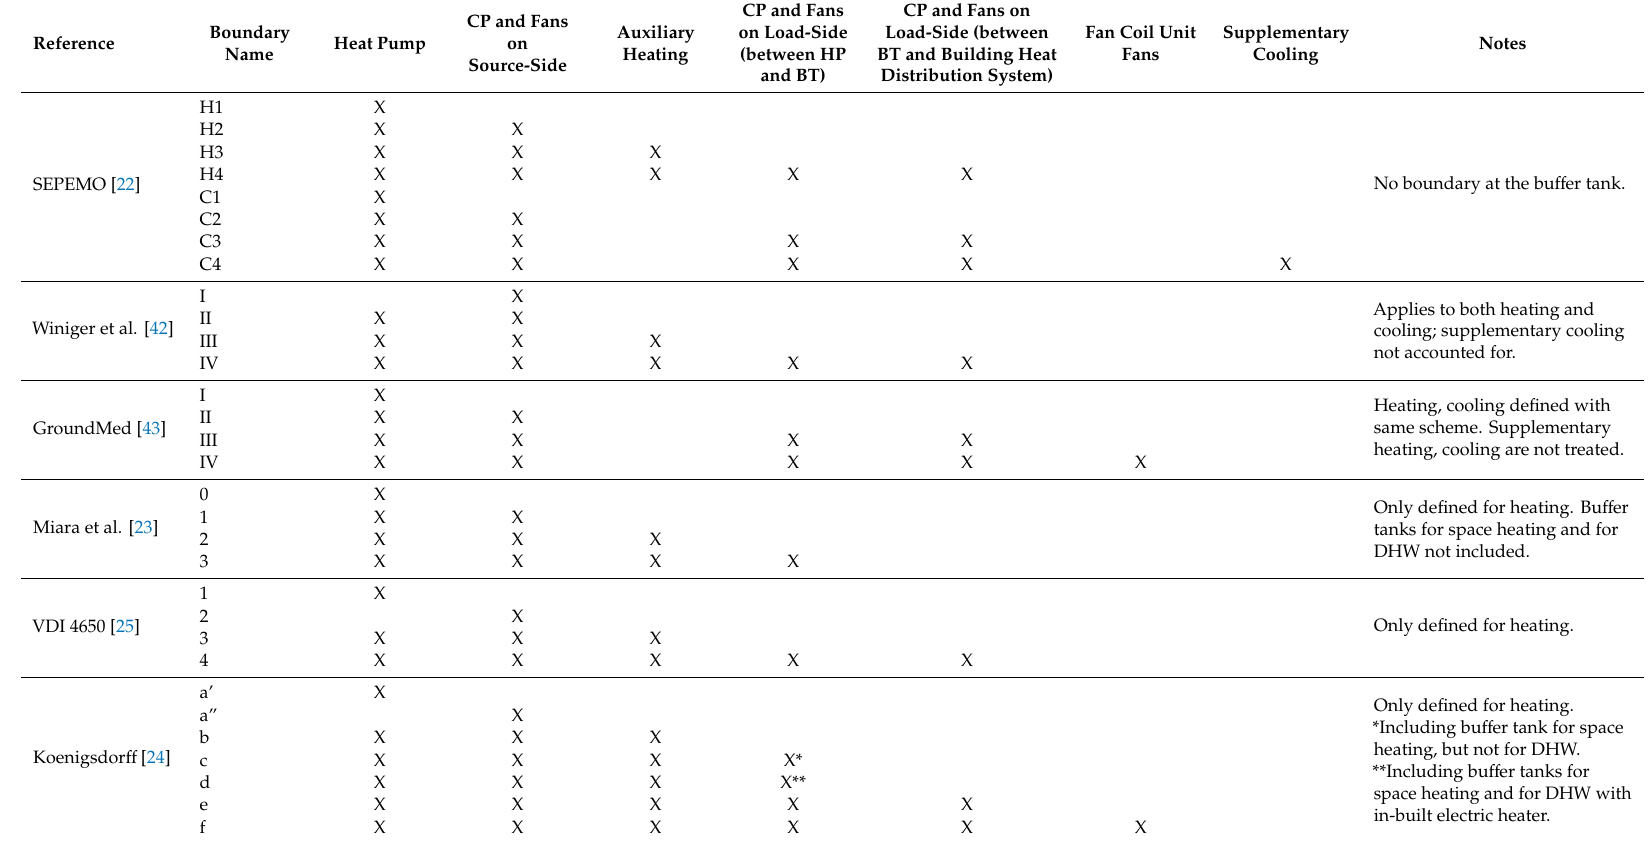
Table 1. System boundaries for seasonal performance factors